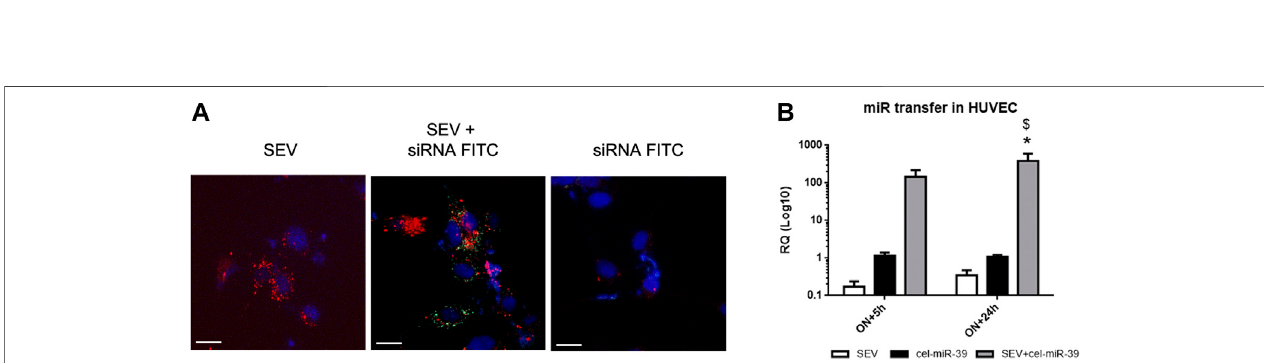
FIGURE2| Exogenous mimic delivery bySEVs toHUVEC targetcells. (A) Incorporation of fl uorescent labeled SEVs (red) alone (SEV) and SEVs co-incubated with FITC conjugated control mimic (green) (SEV+ siRNA FITC) or siRNA FITC alone by HUVEC cells. Cell nuclei were stained with Hoechst dye (blue), × 400 magni fi cation. Whitebar:10 µm. (B) Evaluationofcel-miR-39transferintoHUVECbyrealtimePCR.HUVECweretreatedovernight(ON)withSEV,cel-miR-39aloneorSEV+cel-miR- 39, medium was then replaced, and cells were maintained in culture for other 5 h or 24 h. Data are expressed as RQ ± SD. * p < 0.05 vs. SEV\; $ p < 0.05 vs. cel-